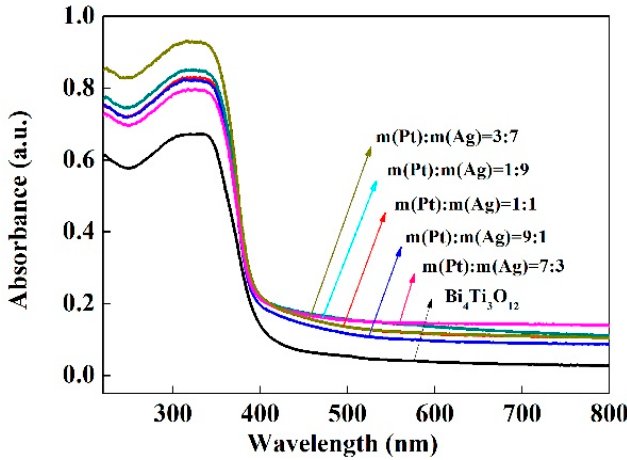
Figure 9. Ultraviolet-visible (UV-Vis) absorption spectra of starting Bi 4 Ti 3 O 12 and (AgPt) 0.001 /Bi 3 Ti 4 O 12 composite photocatalysts prepared by photoreduction method.